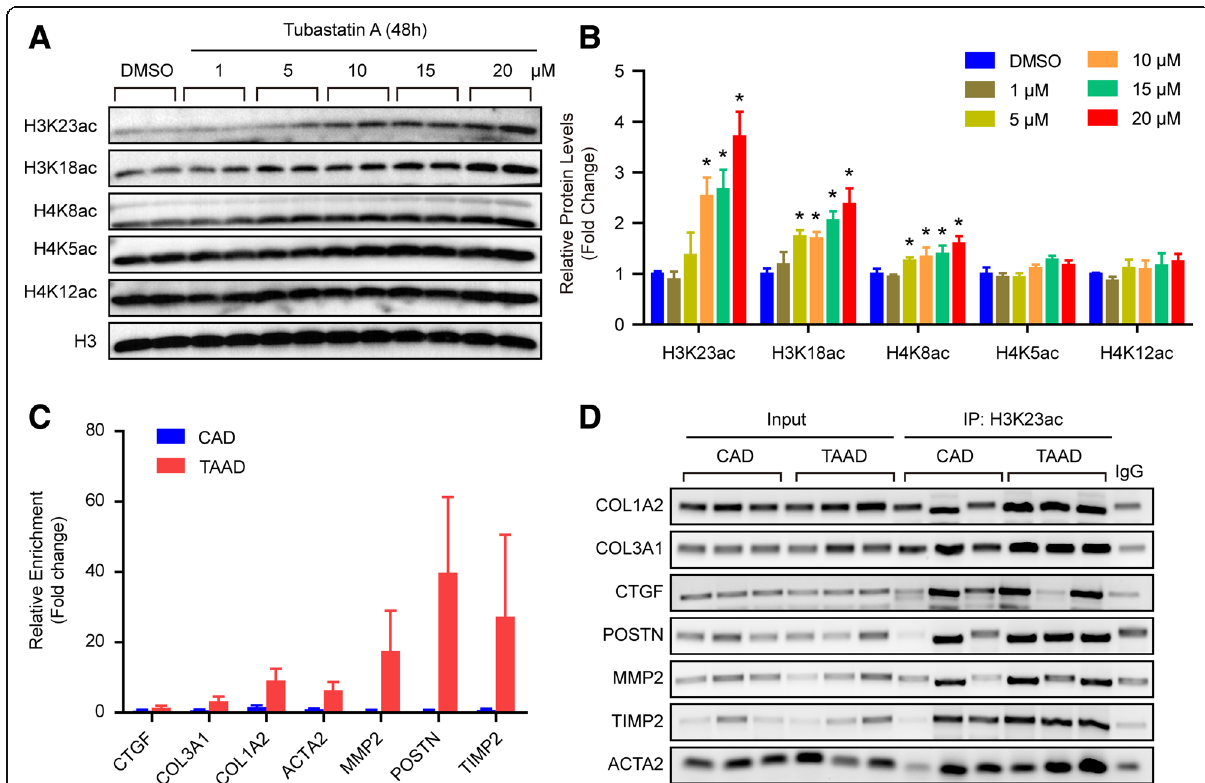
Fig. 2 HDAC6 regulates ECM secretion via H3K23ac. a and b Histone acetylation, including H3K23, H3K18, H4K8, H4K5, and H4K12, were verified in rabbit aortic VSMCs treated with DMSO or different concentrations of tubastatin A ( n = 4 samples per group), * p < 0.05 vs. DMSO. c The statistical result of ChIP-PCR. d The ChIP-PCR products were separated by agarose gel electrophoresis ( n = 6 pooled samples per